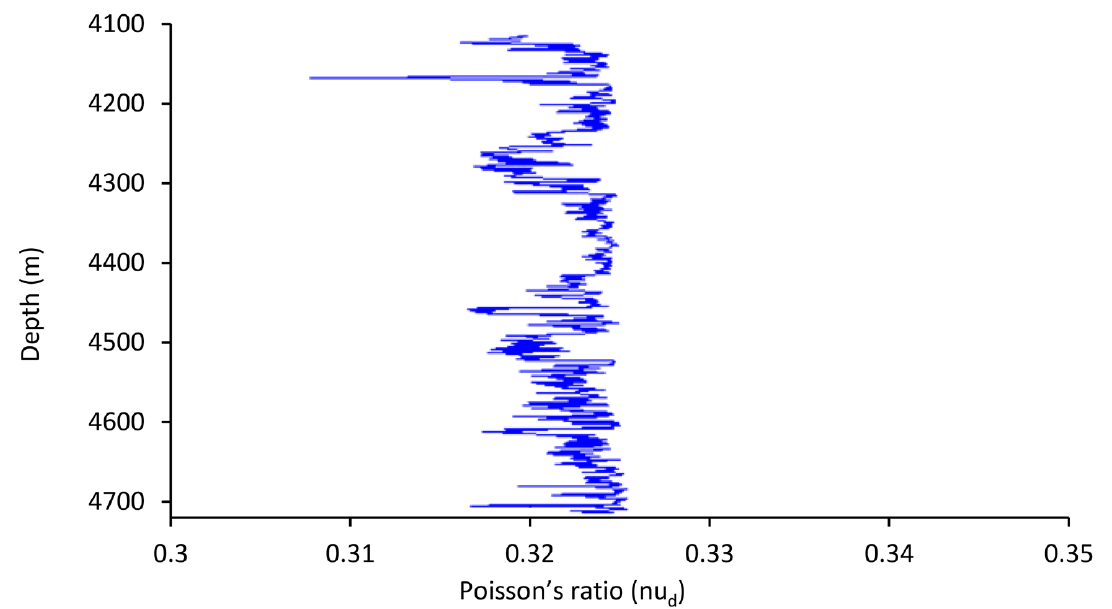
Figure 4. Changes in the dynamic Poisson’s ratio ( nu d ) vs. the depth ( m ) of wellbore-D in the Azar oilfield.